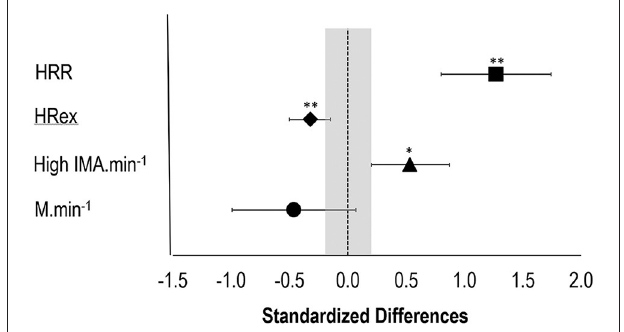
FIGURE 6 | Standardized differences ( ± 90% confidence intervals) in physical performance during a four-a-side small-sided soccer game played in phase 2 in Cancun on day 9 (36 ◦ C − 36% RH) and the last day of phase 2 on day 14 (35 ◦ C − 50%RH). The shaded gray area represents trivial differences (i.e., < 0.20). *Significant difference ( p < 0.05 and ** p < 0.01) between day 9 and day 14. HRR, HR recovery; HRex, HR at exercise; high IMA min − 1 , number